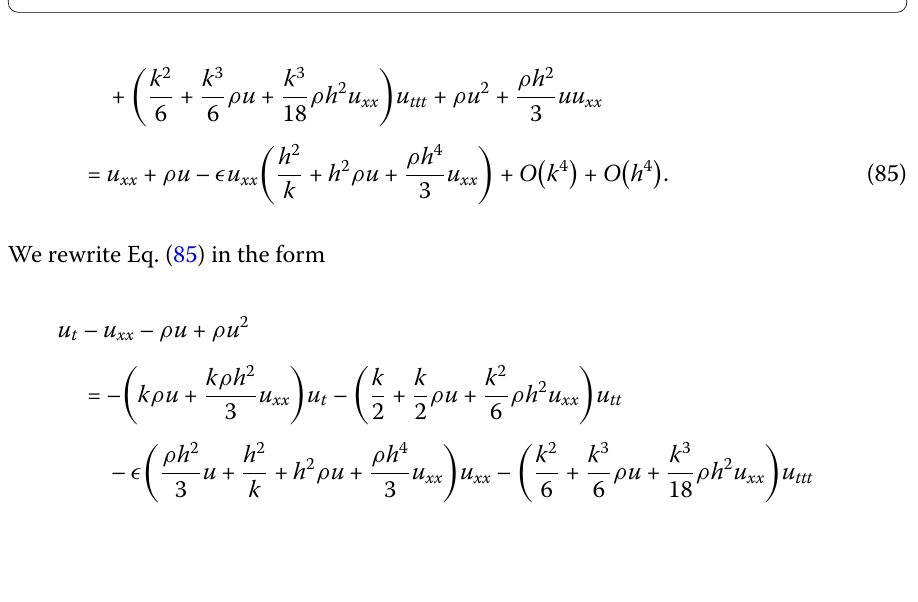
Figure 3 Plot of u against x for Problem 1 using NSFD scheme at time 2.5 × 10 –3 at some different values of k and h =